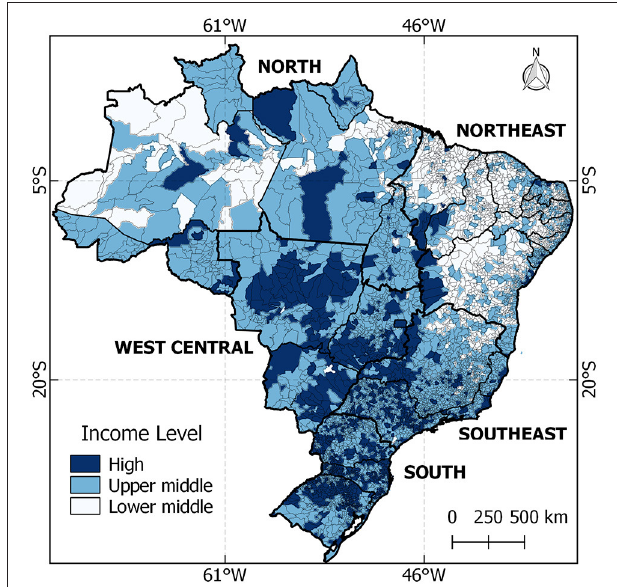
FIGURE 1 | Location of Brazil and distribution of national income for each municipality.